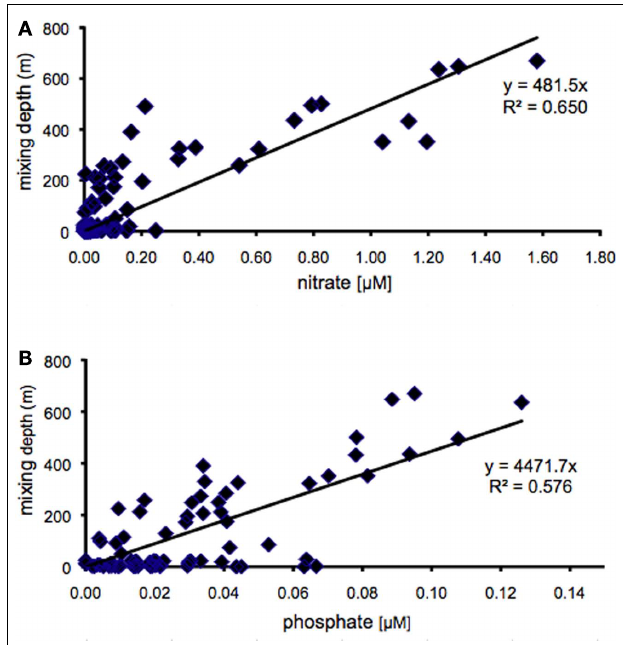
FIGURE 4 | Surface mixed layer concentrations (sampled at 20m) of nitrate (A) and phosphate (B) as function of mixing depth at sampling stationA between 2000 and 2006. Line indicates the curve resulting from linear regression analysis.